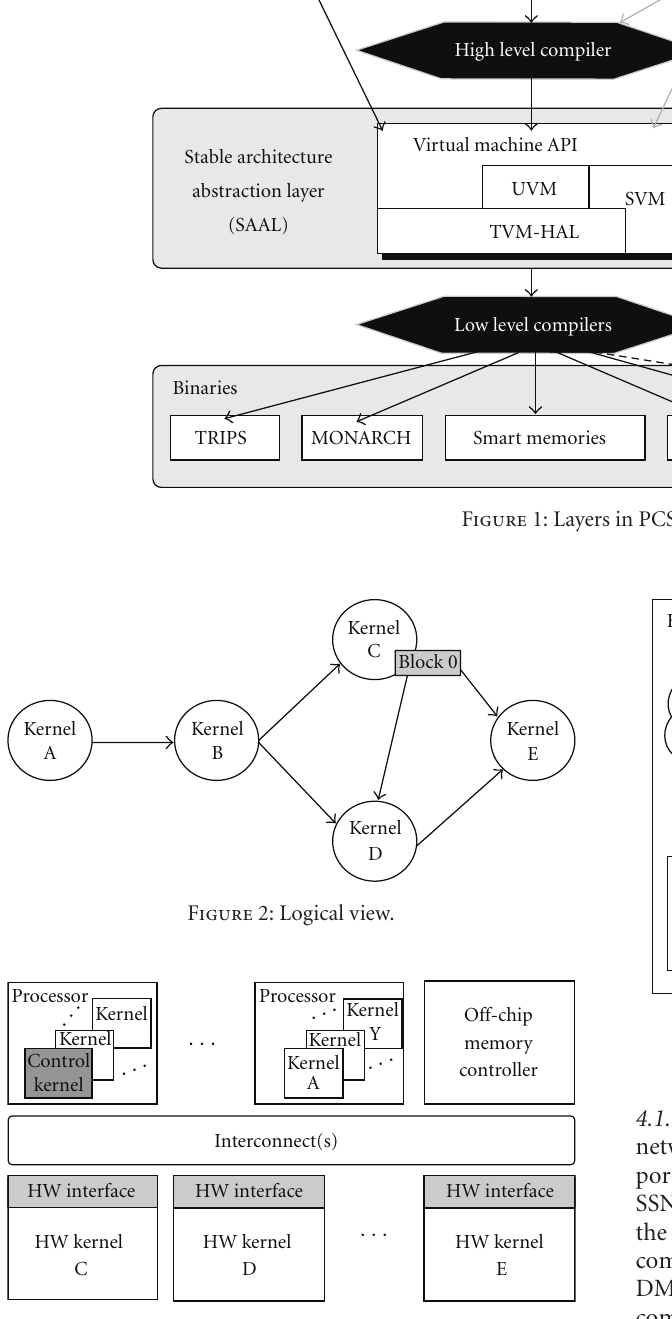
Figure 3: Physcial view.